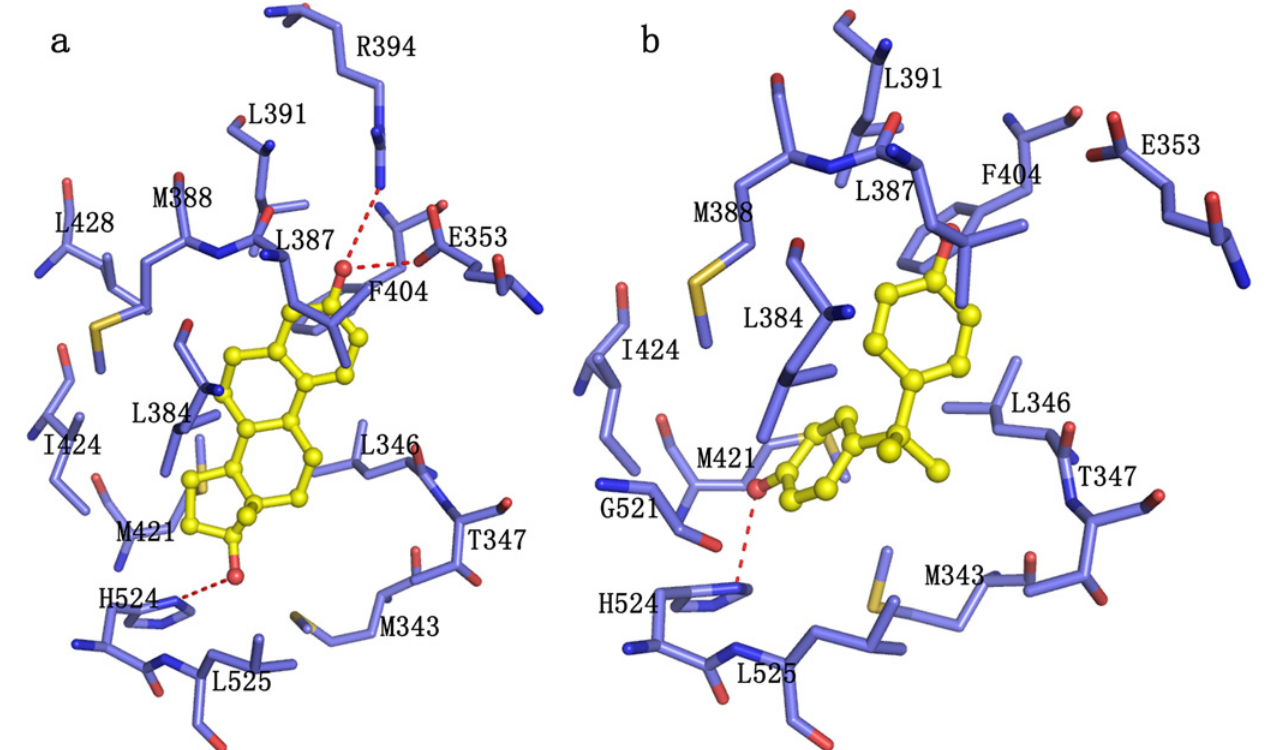
Fig 10. The binding pose of E2 and BPA in the binding site at 100 ns. a) Binding mode of E2; b) Binding mode of BPA. The ligands are shown in yellow ball and sticks. hER α is shown in slate cartoon. Hydrogen bonds formed between the ligand and receptors are indicated as red dashed lines.